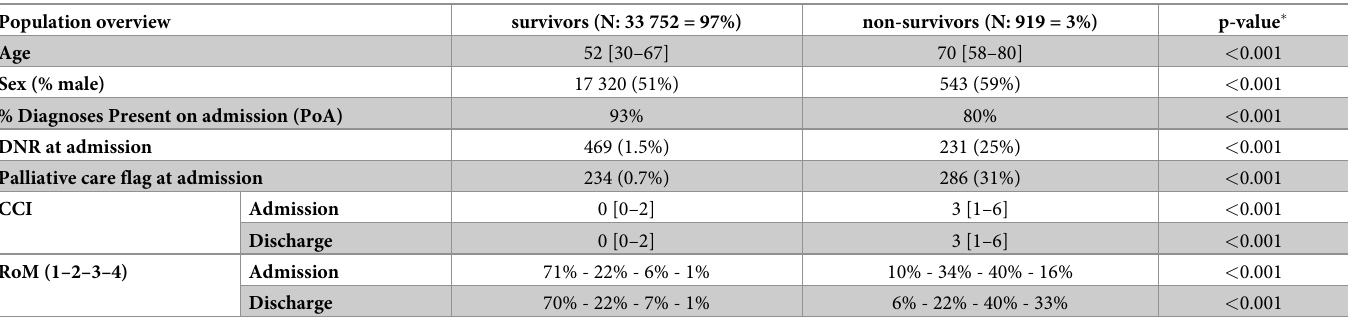
Table 1. Population overview: Characteristics of survivors and non-survivors.